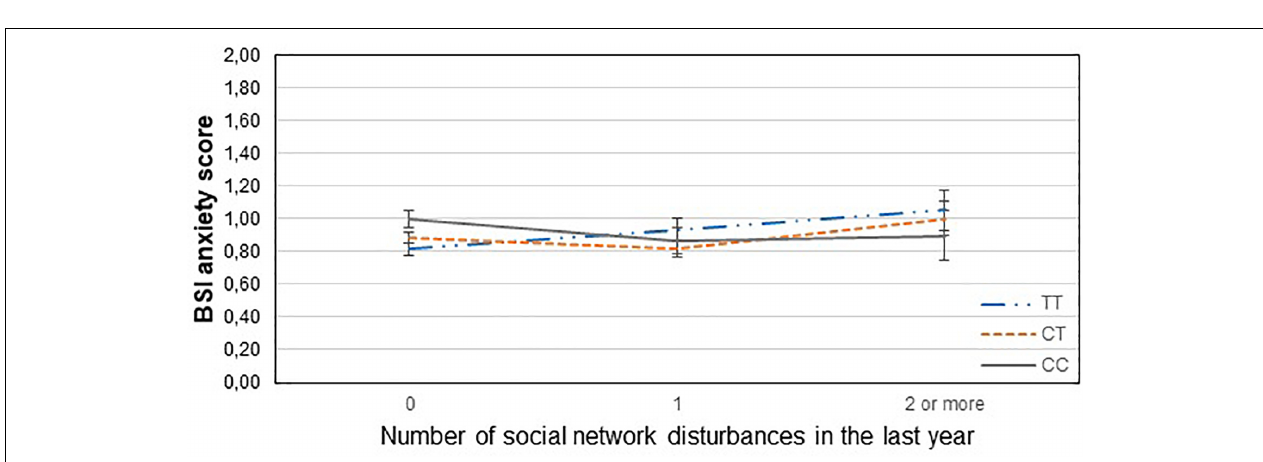
FIGURE 2 | Significant interaction effect of financial difficulties and CNR1 rs7766029 on current depression scores in the total sample. Mean BSI depression scores are displayed with standard error bars, in function of genotype and the number of life events related to financial difficulties occurred within the last year (general linear model performed only for visualization purposes).